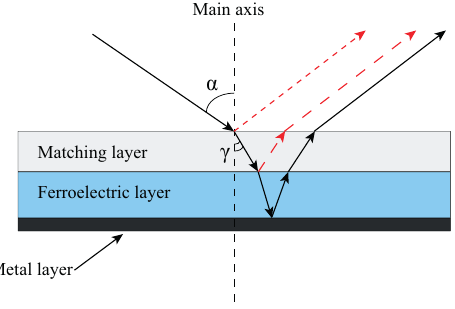
Figure 2. Schematic of the proposed ferroelectric